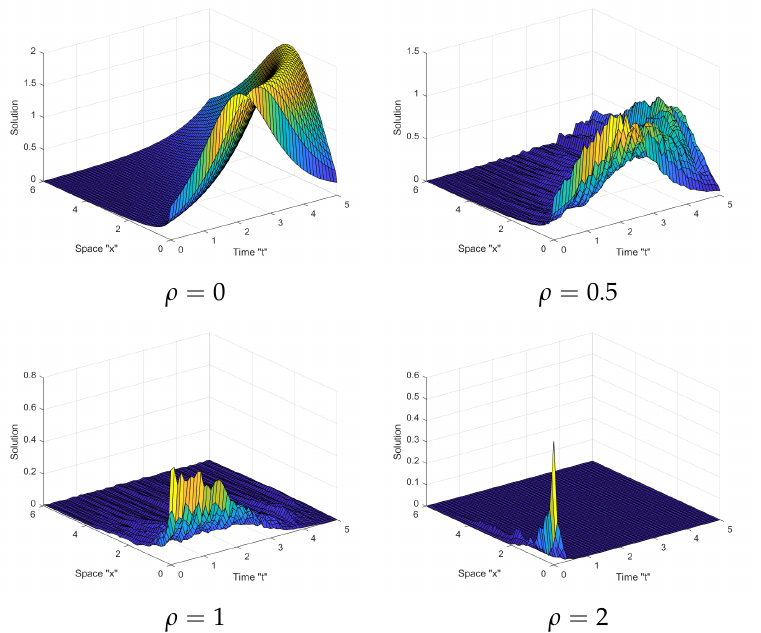
Figure 2. Three-dimensional (3D) plots of the solution (48) with α = 0.5. Thus, we can deduce from Figures 1–3 that the multiplicative Brownian motion influences the solutions of SFSBE and it stabilizes the solutions around zero.